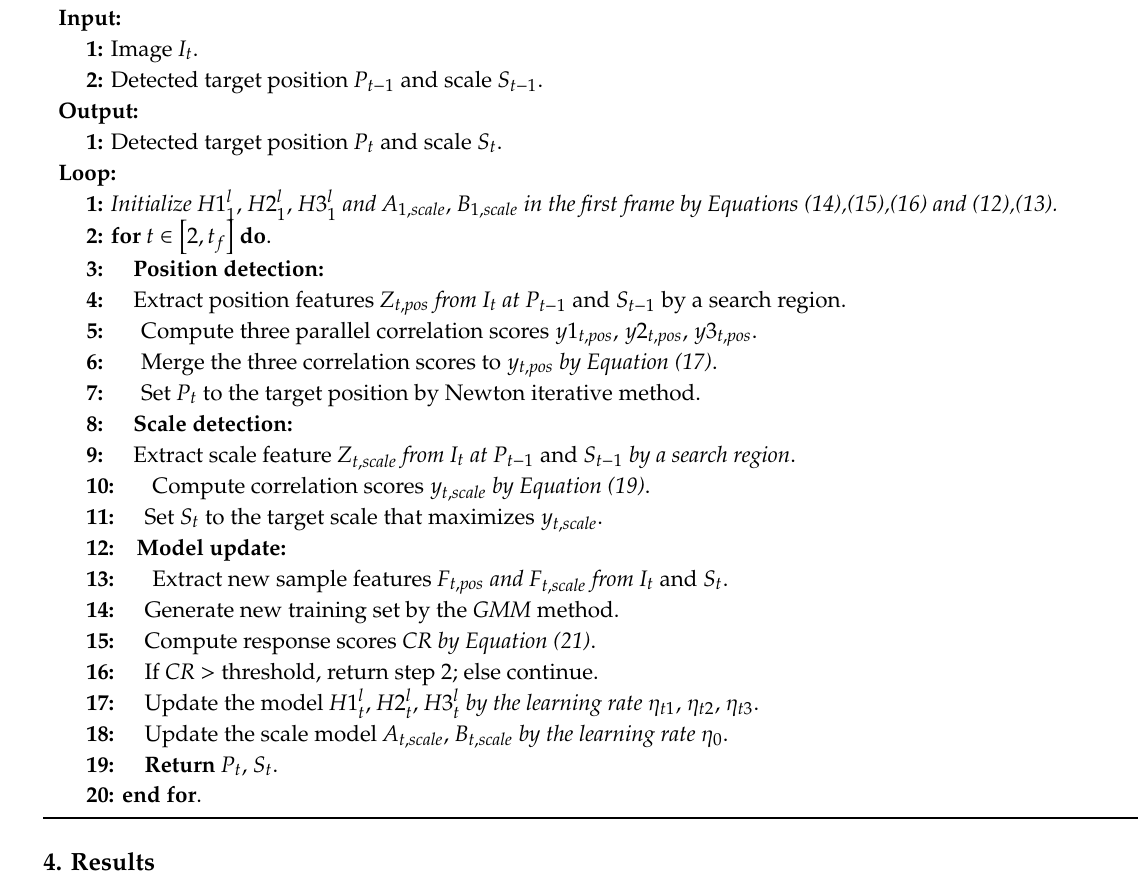
Algorithm 1 : Parallel Three-Branch Correlation Filters Tracking Algorithm Based on a Confidence